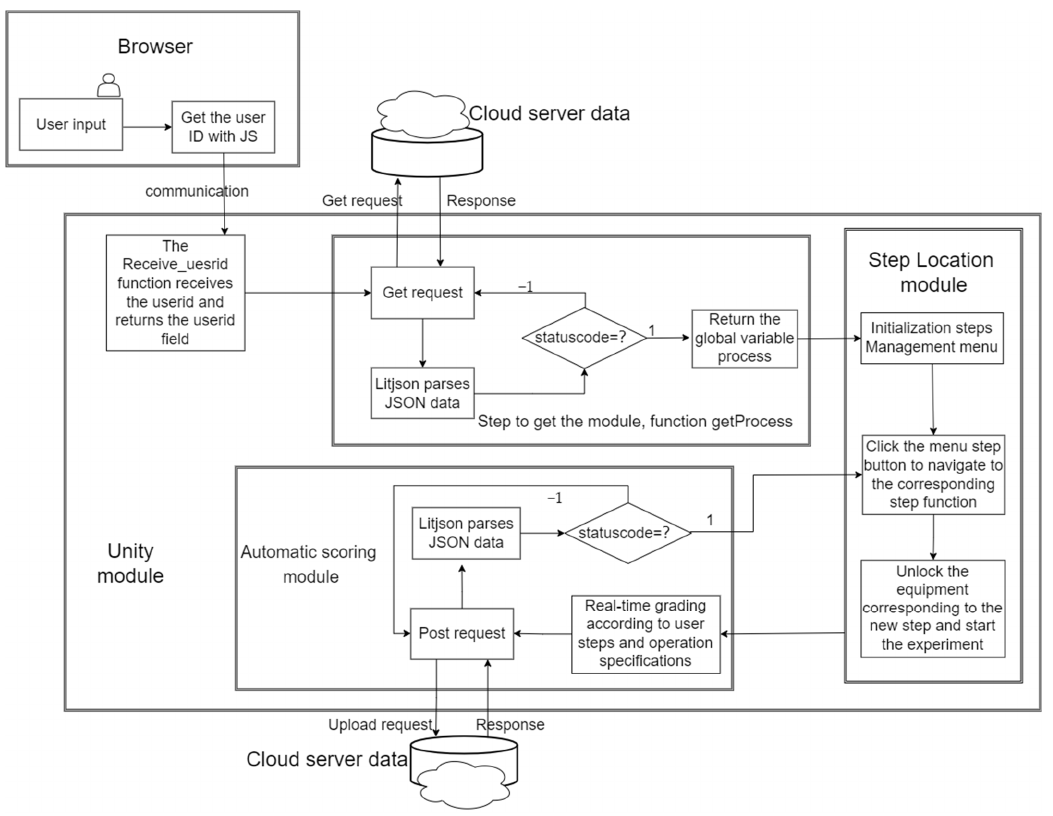
Figure 12. Step control flow chart.